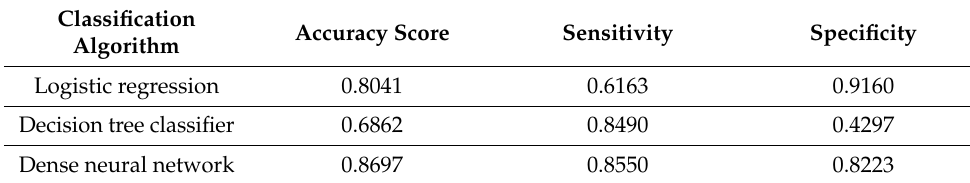
Table 3. The statistical results of the three